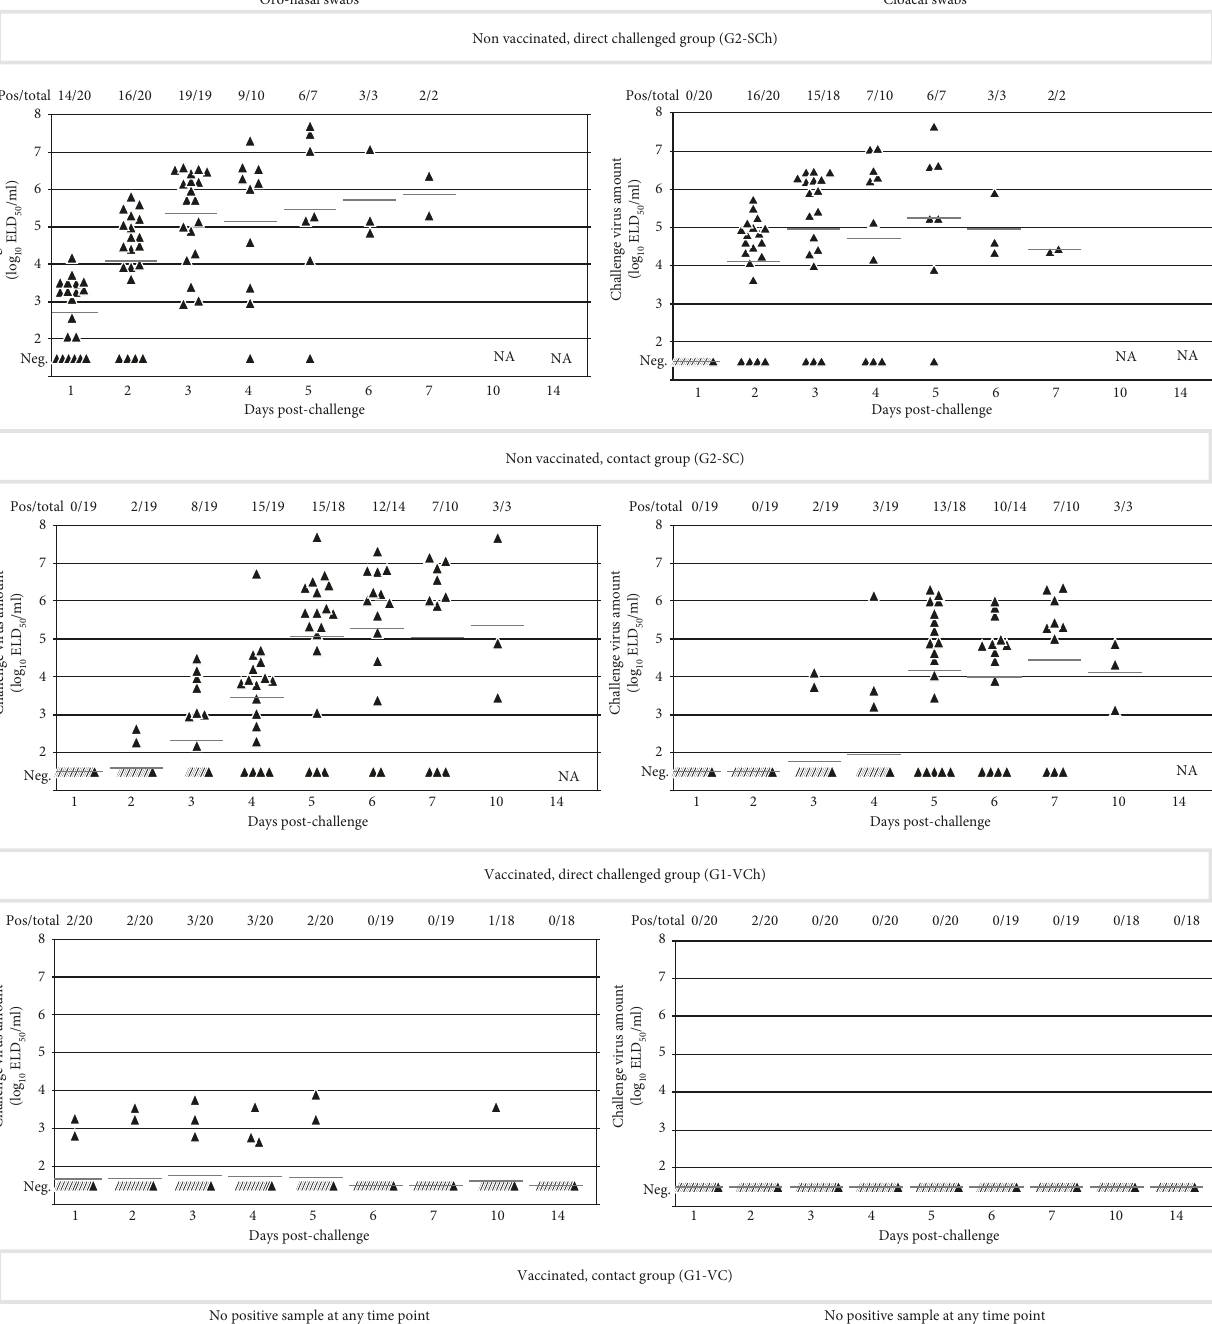
ELD /ml in the 10 50 10